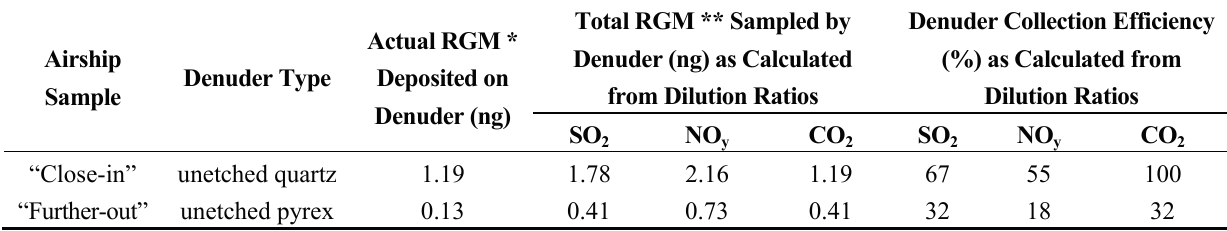
Table 1. Estimated denuder collection efficiencies for in-plume samples obtained 28 February 2008. Total RGM ** Sampled by Actual RGM * Denuder (ng) as Airship Denuder Type Deposited on Sample Denuder (ng)